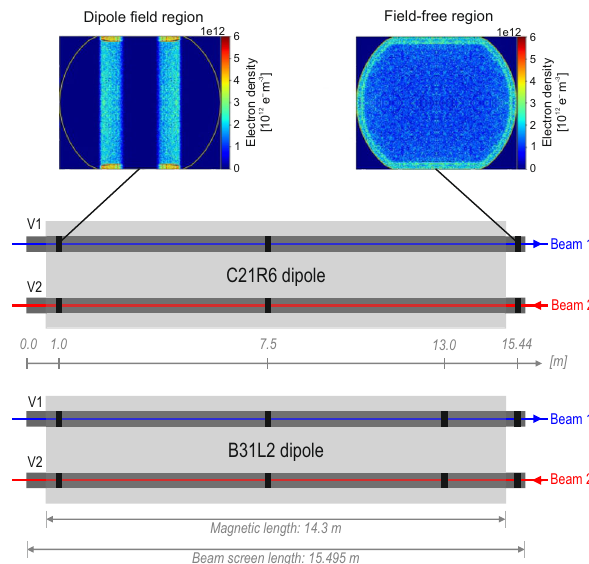
Fig. 2 Beam screen sampling positions. Positions of the beam screen sections cut for analysis (black stripes) for Low Heat Load C21R6 and High Heat Load B31L2 LHC dipoles, and simulated electron cloud density distributions in the fi eld and fi eld-free